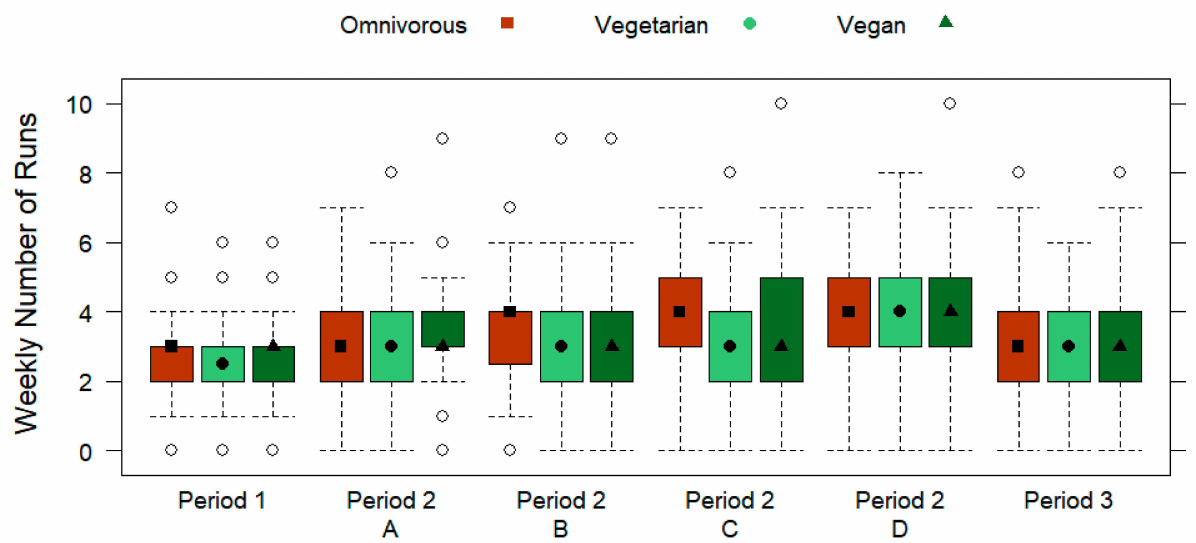
Figure 4. Weekly number of runs (displayed by three training periods, including the A, B, C, and D training types of period 2) of omnivorous, vegetarian, and vegan runners. Data are presented by box plots.